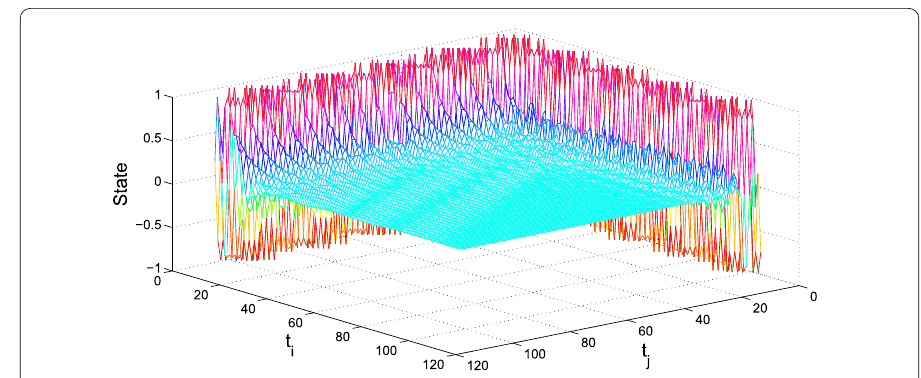
Figure 2 State trajectories of system (33) with a feedback gain matrix K